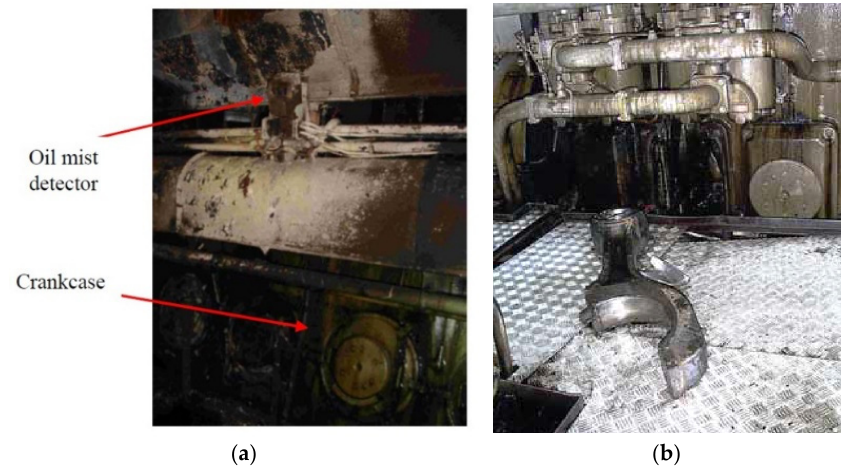
Figure 5. Damage of trunk piston engine after explosion in crankcases of trunk piston engines: ( a ) burned oil mist detector after failure of the engine lubrication system [53]; ( b ) conrod as found after explosion caused by failure of piston guide part of Wärtsilä Vasa 32 engine [54].